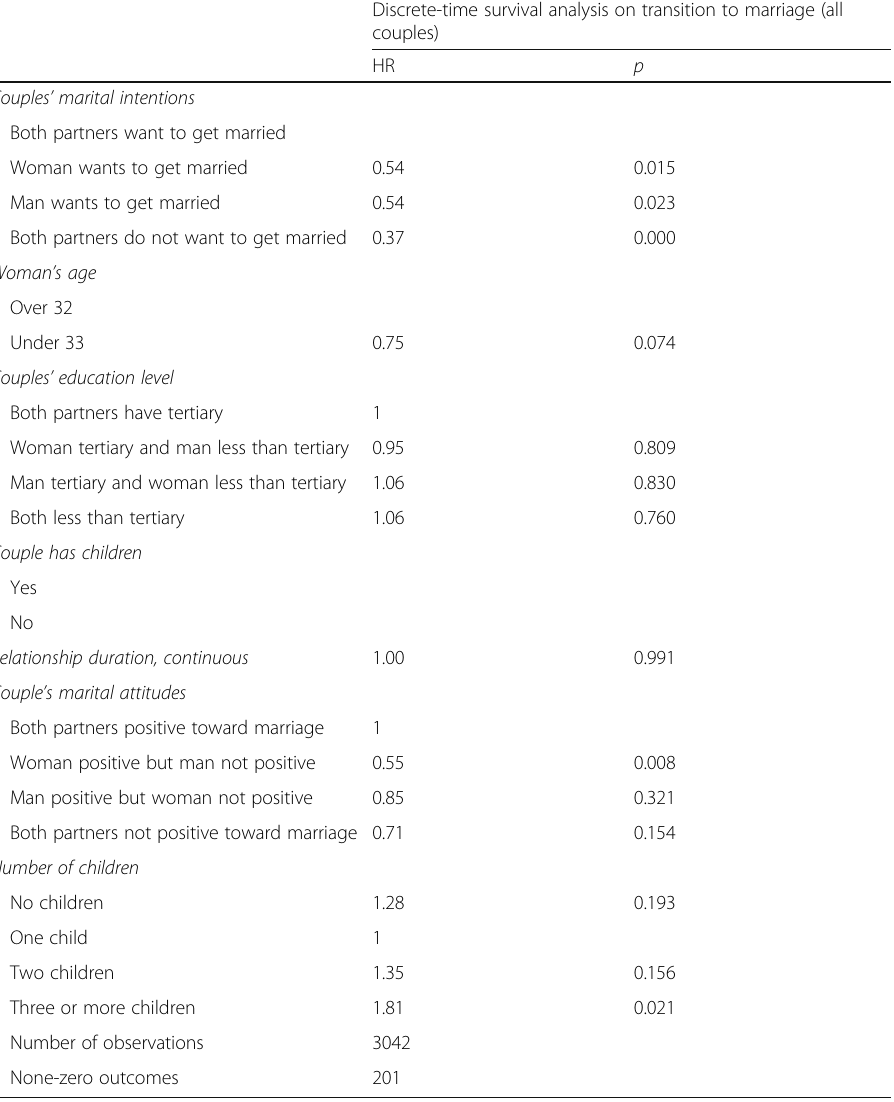
Table 8 Hazard ratios of marriage by marital intentions. Sensitivity analyses using complementary log-log models (hazard